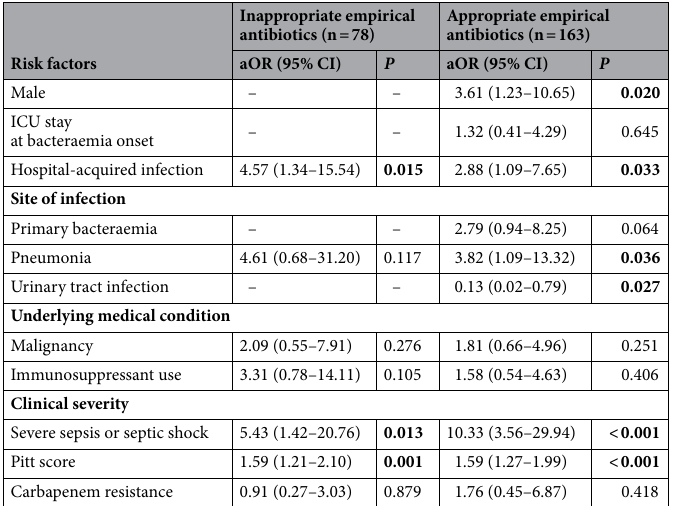
Table 4. Multivariate analysis of risk factors for treatment failure in patients with Pseudomonas aeruginosa bacteraemia, according to the appropriateness of empirical therapy. aOR, adjusted odds ratio; CI, confidence interval; ICU, intensive care unit. Significant values are in